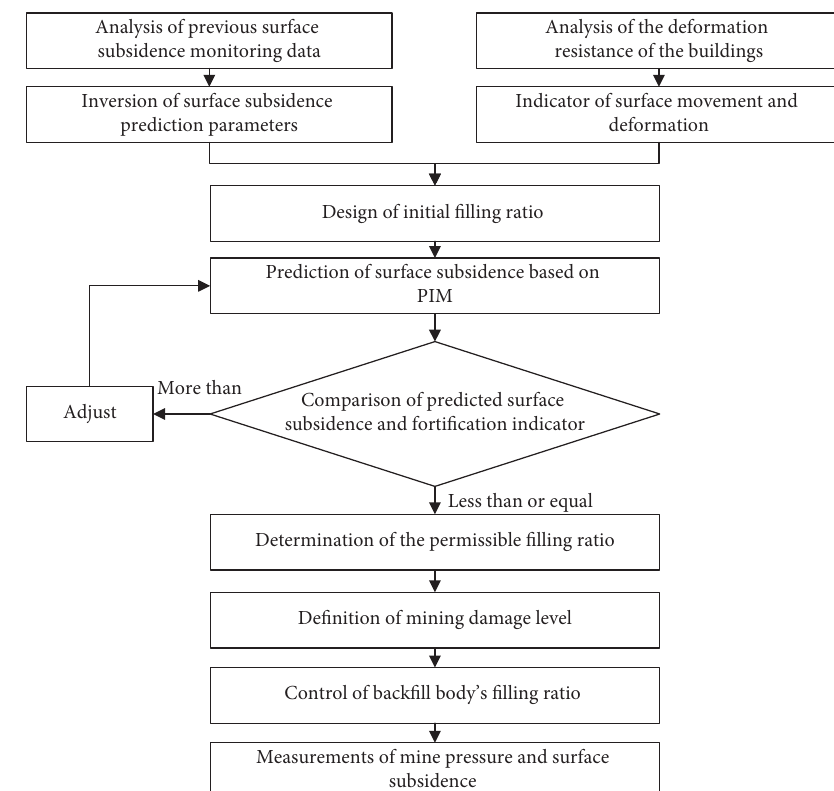
Figure 9: Design process for surface subsidence control of deep solid backfill mining under